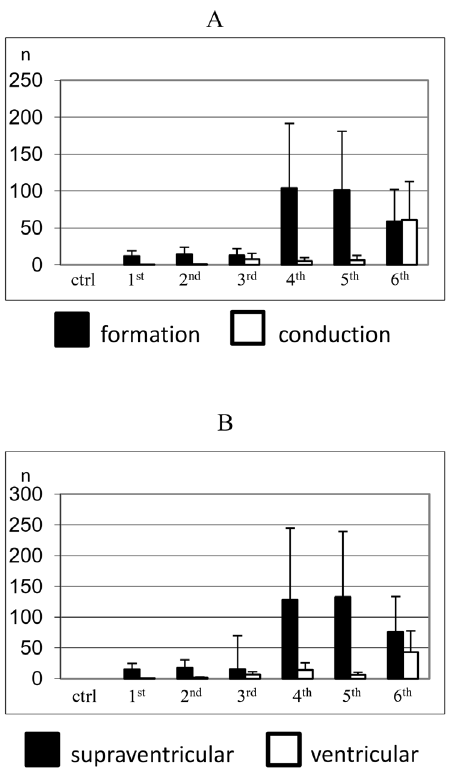
Figure 4. Arrhythmia type and location. Histograms relating to the type (A) and the location (B) of arrhythmic events of control and aged animals which occurred during telemetry ECG recording. Number of arrhythmic events was evaluated on the ECGs from the 1 st to the 6 th month after radiotelemetry transmitter implantation, as compared to controls